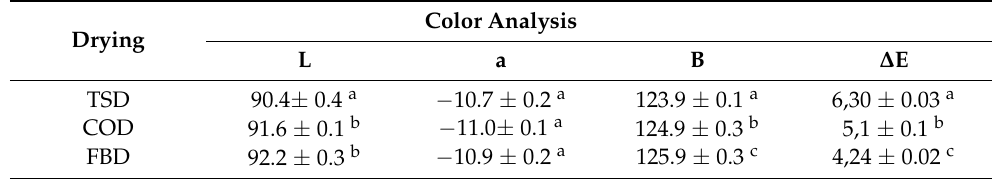
Table 2. Effect of drying treatments on the CIElab